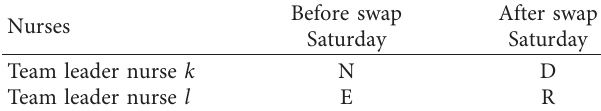
Table 8: An example of VNS1.